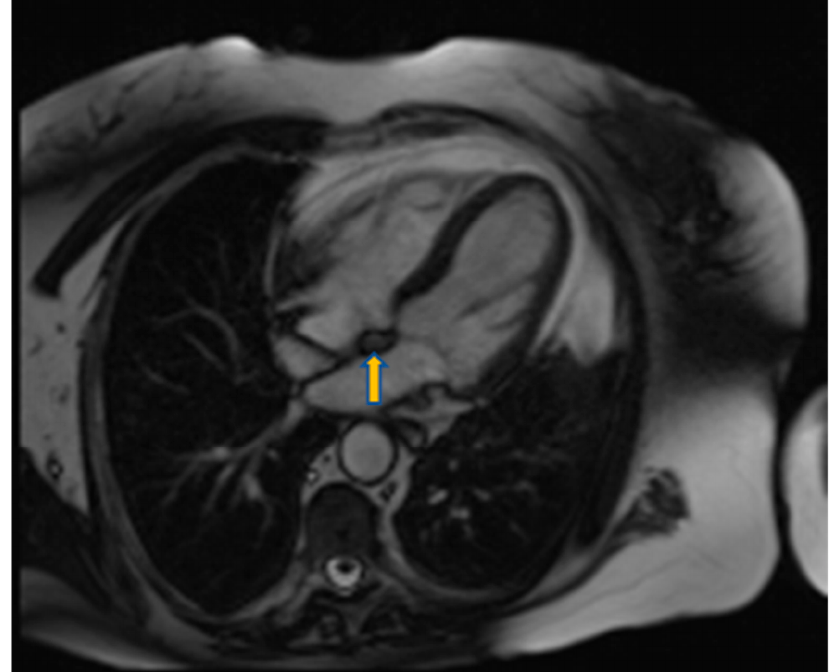
Figure 11. Four chamber view using SSFP sequence of a 70-year-old man showing lipomatous hypertrophy of the atrial septum (arrow).